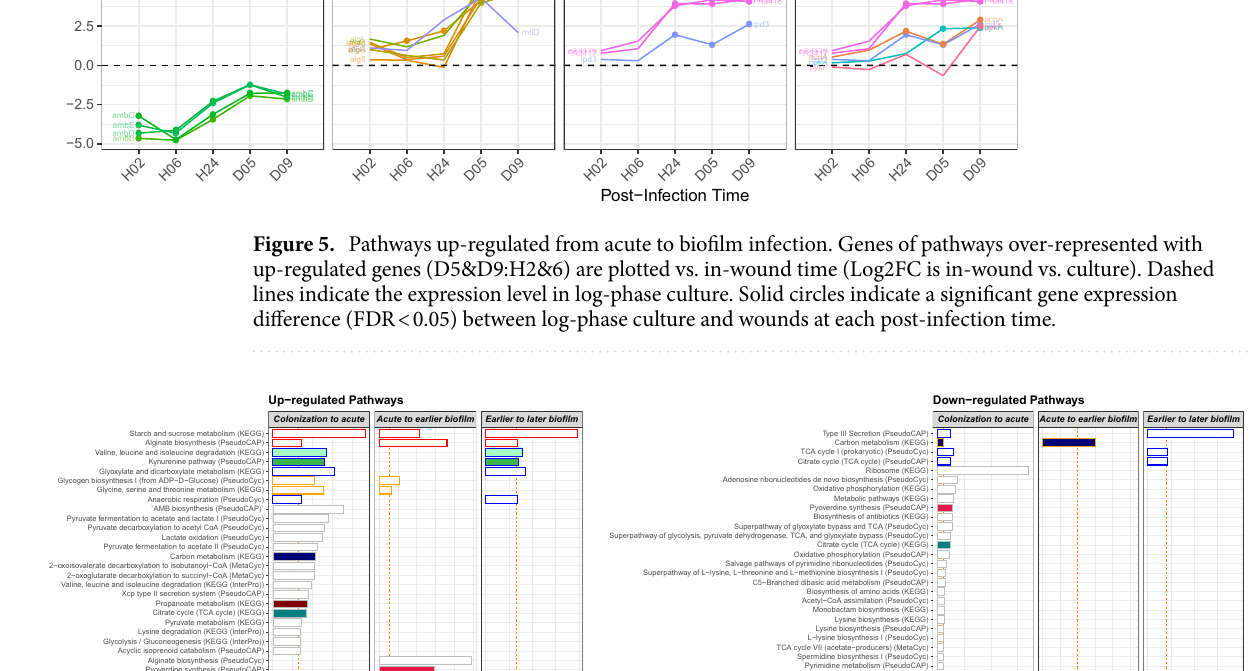
(MetaCyc)2−oxoisovalerate decarboxylation to isobutanoyl−CoA (MetaCyc)Carbon (PseudoCAP)Valine, leucine and isoleucine degradation (KEGG (InterPro))2−oxoglutarate decarboxylation to succinyl−CoA (KEGG)Propanoate metabolism (KEGG)Xcp type II secretion system Pyruvate metabolism (KEGG)Citrate cycle (TCA cycle) (PseudoCAP)Glycolysis / Gluconeogenesis (KEGG (InterPro))Lysine degradation (KEGG (InterPro)) (PseudoCAP)Alginate biosynthesis (PseudoCyc)Acyclic isoprenoid catabolism (PseudoCAP)Apr type I secretion system (PseudoCAP)Pyoverdine synthesis (KEGG)Pyochelin synthesis (PseudoCAP)Ethanol oxidation pathway (PseudoCyc)Pyrroloquinoline quinone biosynthesis (PseudoCAP)Fructose and mannose metabolism (PseudoCAP)Biosynthesis of siderophore group nonribosomal peptides (KEGG)Salicylate biosynthesis I (PseudoCyc)Creatinine degradation I (PseudoCyc)Pilin biosynthesis (KEGG)Beta−Lactam resistance (KEGG)Superoxide radicals degradation Trehalose biosynthesis V (MetaCyc)ABC transporters (PseudoCyc)L−methionine biosynthesis I (PseudoCyc)Pyrroloquinoline quinone (PQQ) biosynthesis (PseudoCAP) biosynthesis III (from L−homocysteine) (PseudoCyc)L−homocysteine and L−cysteine interconversion